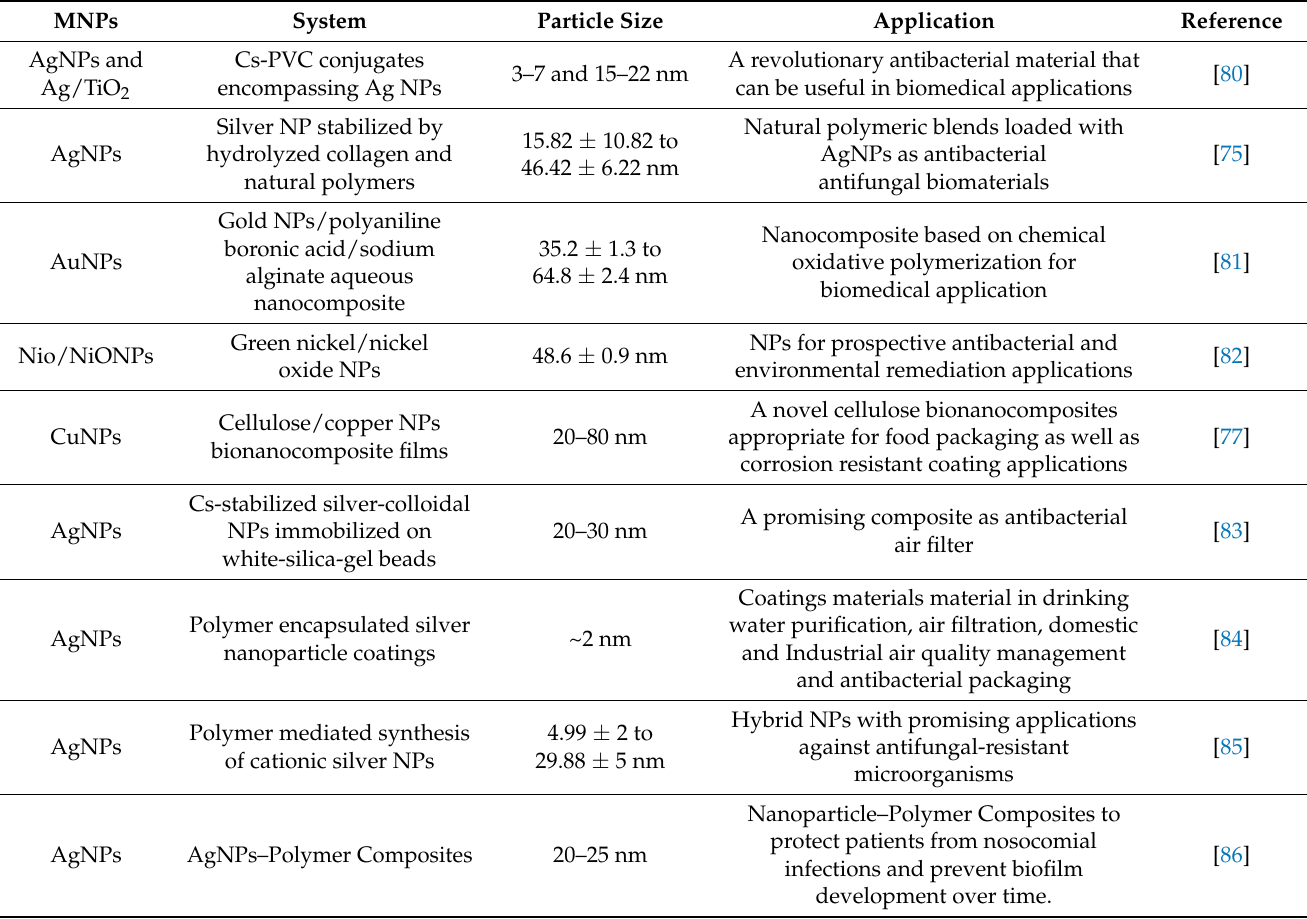
Table 2. Different forms of polymeric -based MNPs and their